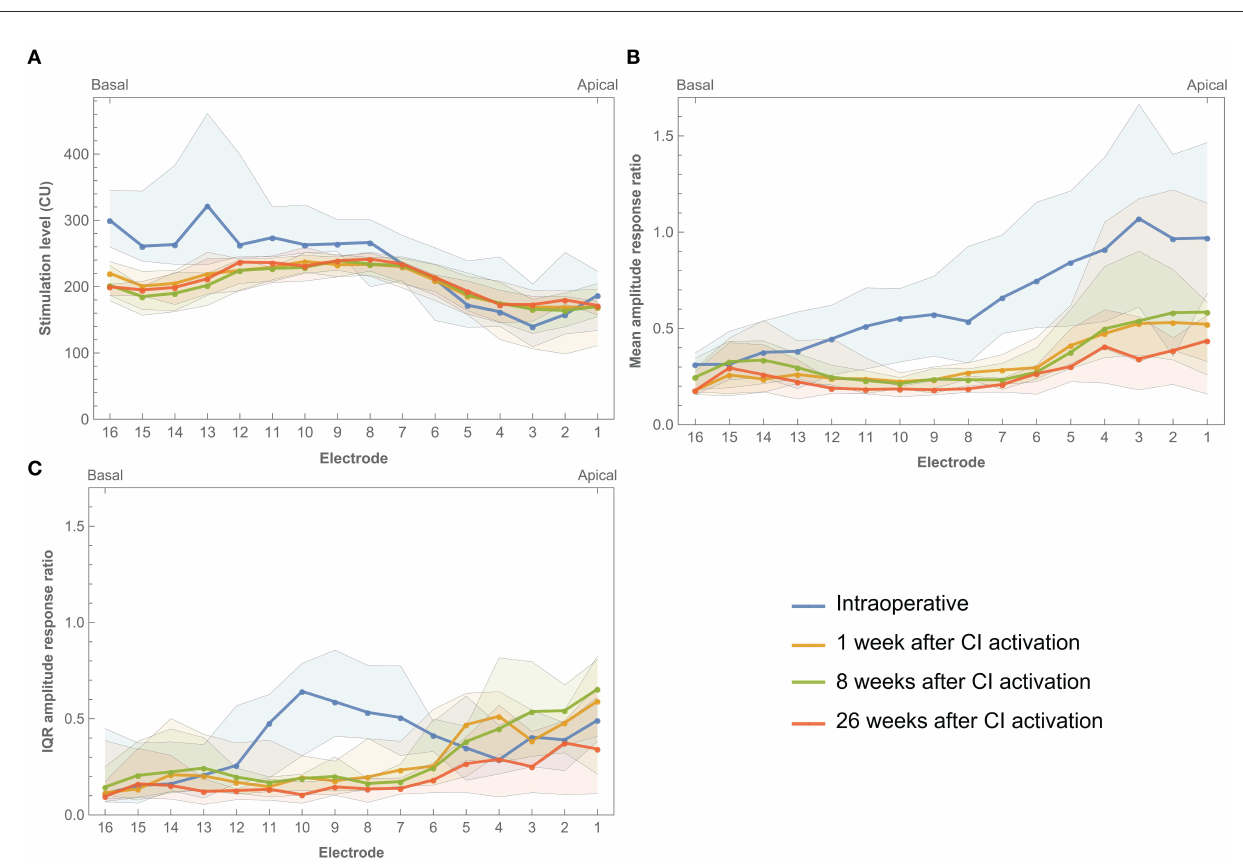
FIGURE4 Electrically evoked compound action potential estimates across the electrode array measured intraoperatively and during three return visits within the first 6 months of CI rehabilitation. (A) Median 100 µ V ECAP, which describes the stimulation level needed to elicit an ECAP response of 100 µ V. (B) Mean amplitude response ratio, which describes the mean of ratios between stimulation level and ECAP response where a higher value indicates more ECAP response for a given input. (C) IQR amplitude response ratio, which describes the interquartile range of ratios between stimulation level and ECAP response. Bands indicate the first and third